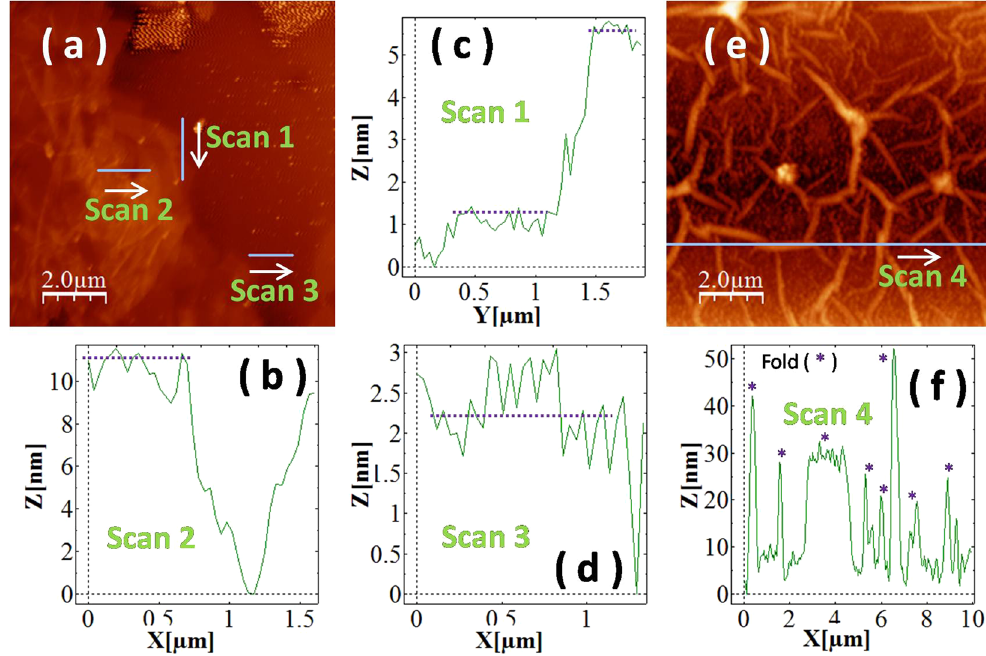
Figure 4. ( a ) AFM image of a drop coated GO film. ( b ), ( c ) and ( d ) height profile data of scan2, scan1 and scan3 respectively in ( a ). ( e ) AFM image of drop casted GO film with corrugation and wrinkles. ( f ) Height profile of the GO film along the wrinkles obtained in ( e